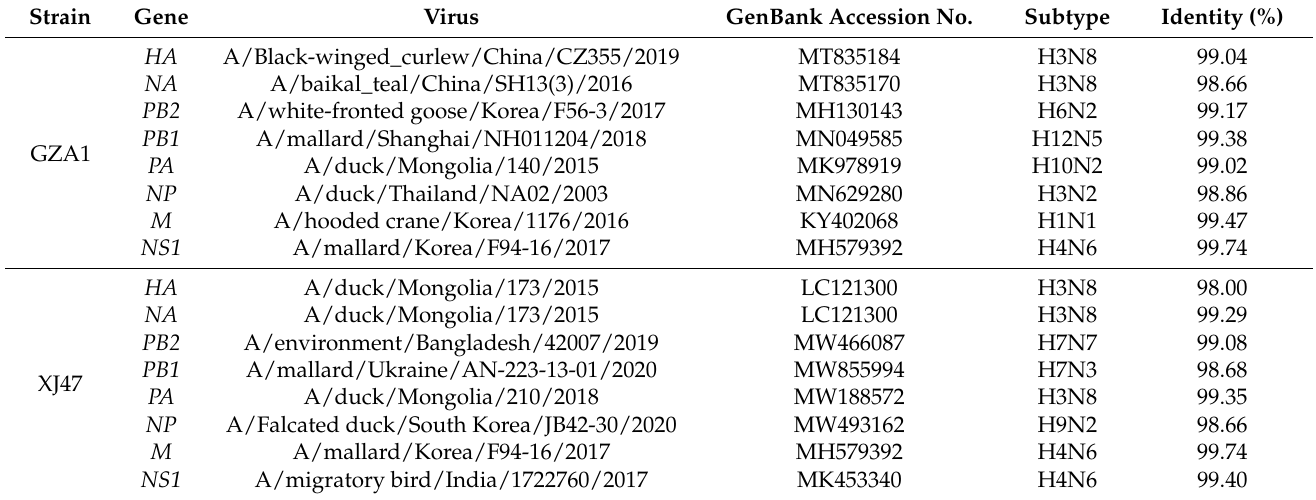
Table 1. Nucleotide sequences with the highest homology to GZA1 and XJ47 in the GenBank database.